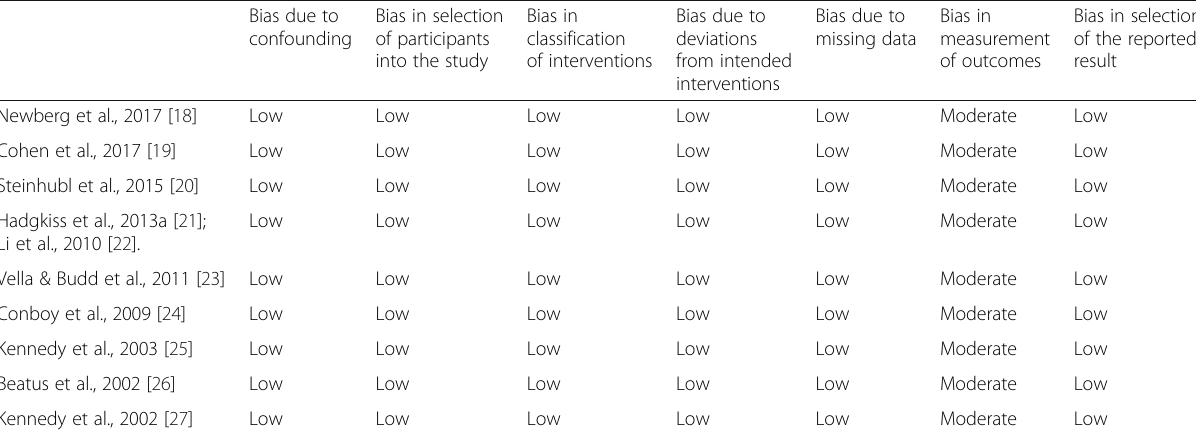
Table 6 Risk of bias summary for Longitudinal Cohort Studies